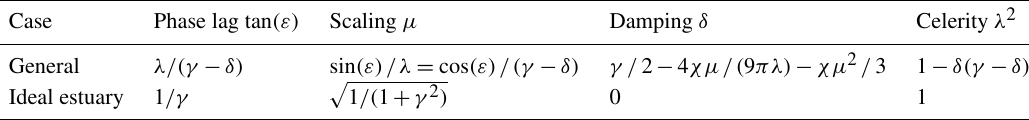
Table 2. Hybrid solution of tidal wave propagation in convergent estuaries (Cai et al., 2015).